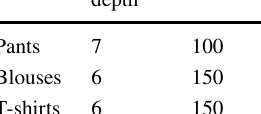
Table 2 Optimal parameters of the final random forest models for the four datasets